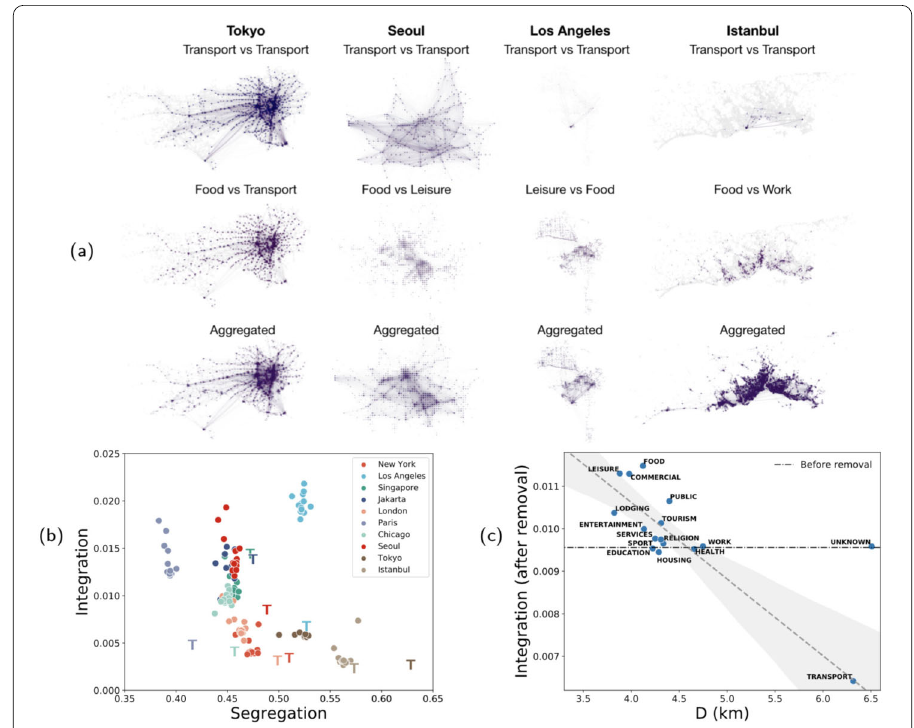
Figure 5 Disentangling functional flows. ( a ) We illustrate the strikingly distinct views on the functional organisation of a city extracted by isolating intra- or inter-layer flows. These maps outline the different “cities within the city” which we isolate by decoupling the urban flows into activity-aware multilayer networks. ( b ) We define the multilayer networks of human flows for each city (encoded by color) by stratifying flows according to different macro-categories used in this work (see Methods). Each point corresponds to integration and segregation measured after removing a specific layer of activities. The letter ‘T’ marks values associated to the removal of the transport layer, which strongly influence the urban functional connectivity (see Fig. 6). ( c ) Average functional integration for different activity categories. We observe a relationship between the average distance covered D in movement inside one layer and the value of integration (see Additional file 1, Fig. 7 for segregation). The regression is done excluding the outlier the unclassified